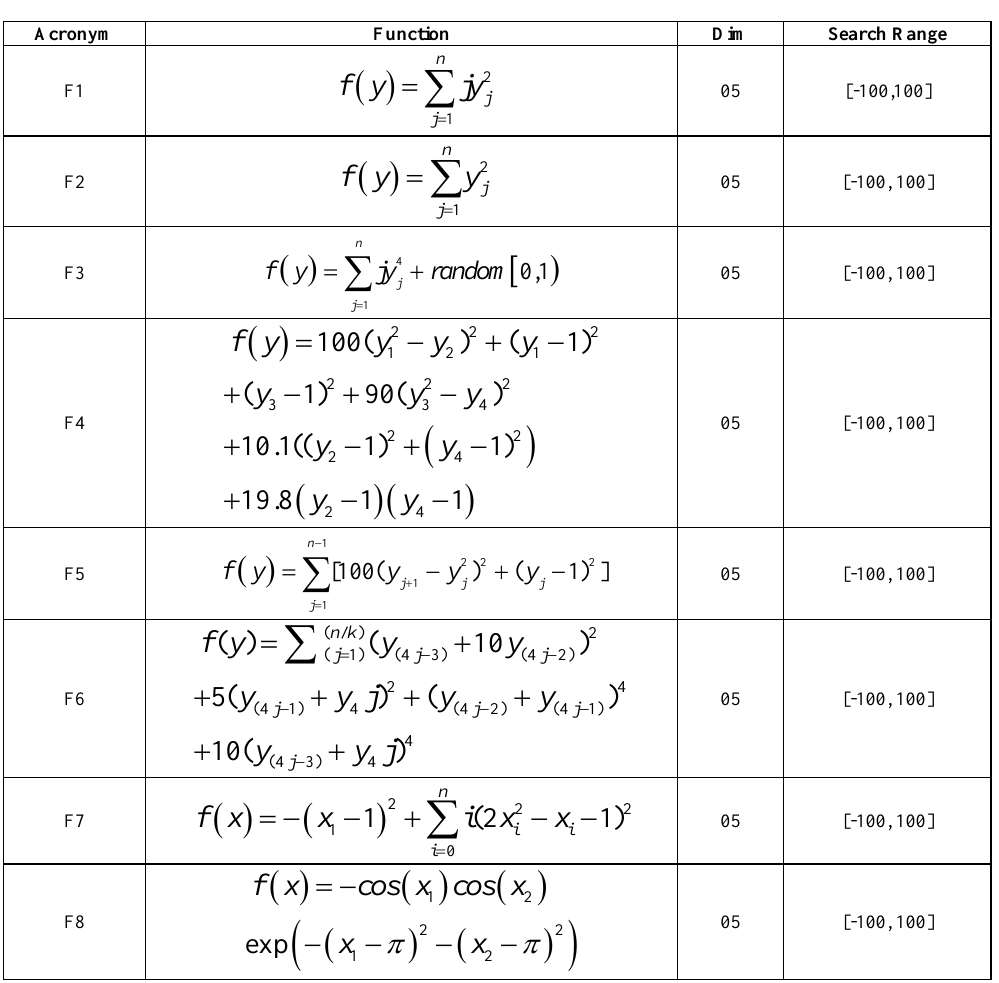
Table 1. Unimodal benchmark